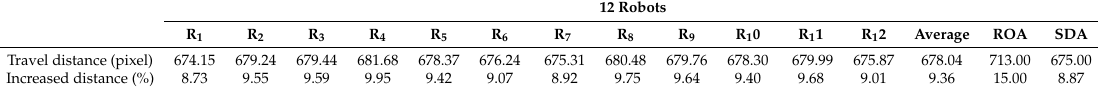
Table 6. Multi-robot navigation performance comparison (two and four robot cases).